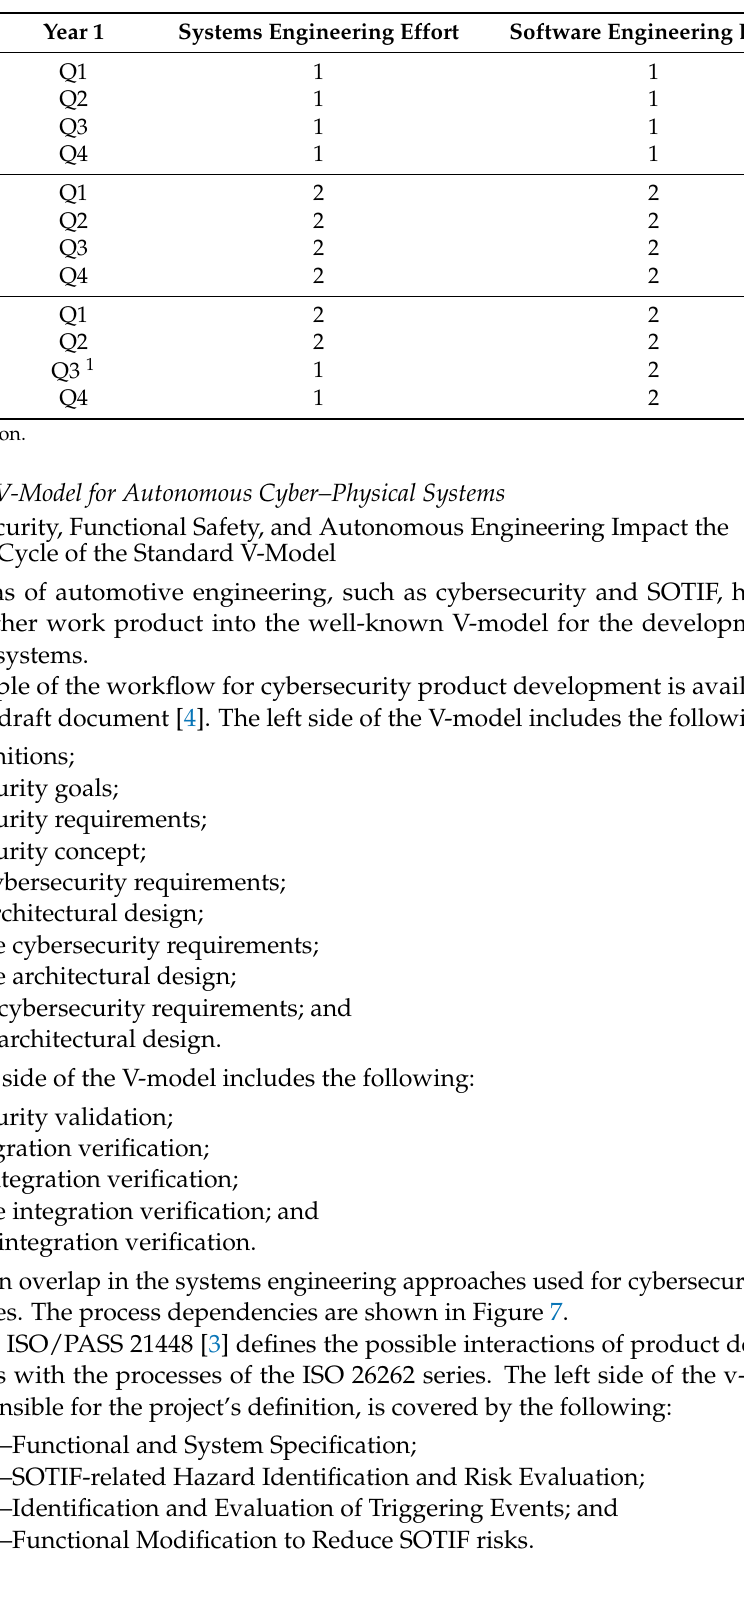
Table 7. Re-estimated engineering effort for the cybersecurity design of the V2G gateway ECU after 1 year of